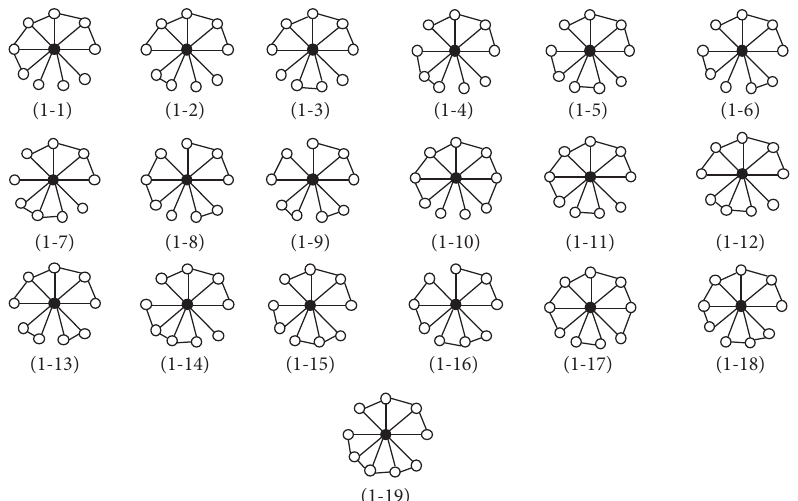
Figure 1: Vertex v is a 9-vertex, the various cases of f